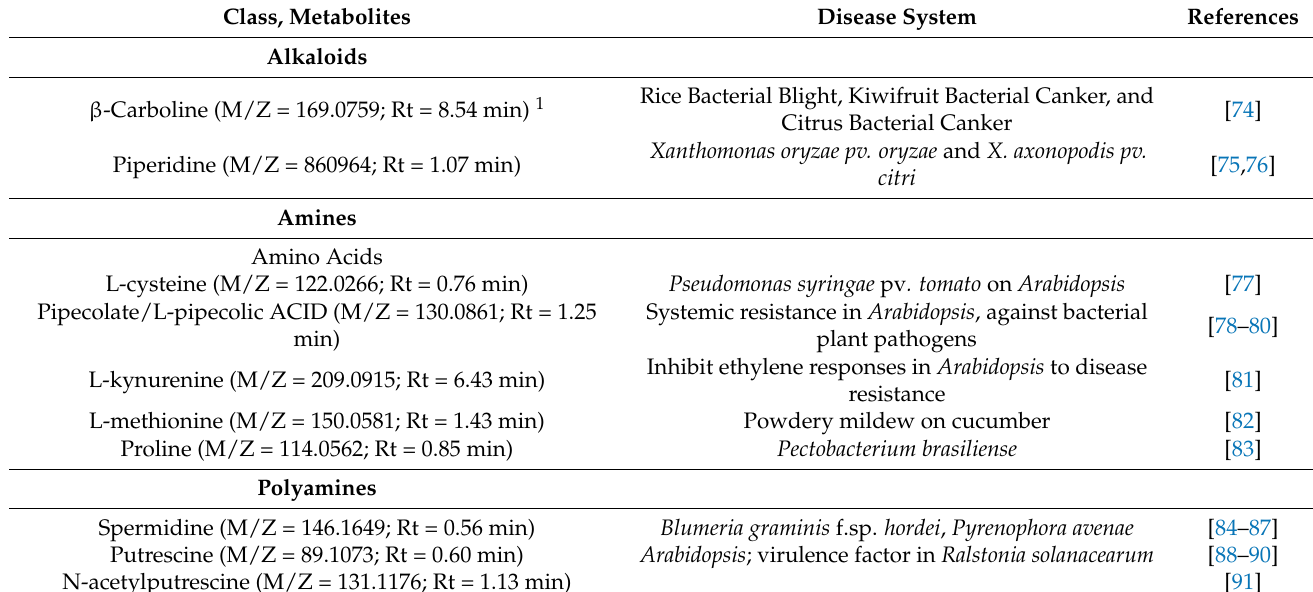
Table 3. Annotated metabolites in X. perforans that have shown promise in plant disease